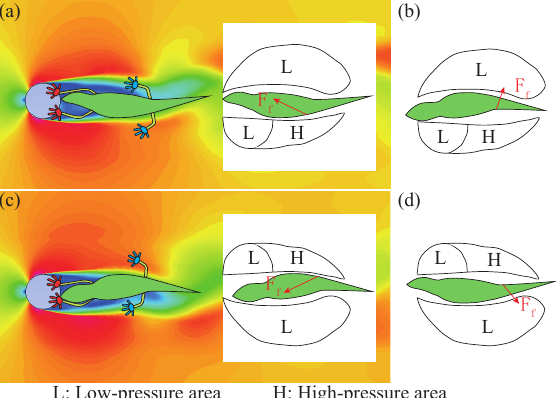
Figure 14. Influence of air pressure on a lizard behind an obstacle. When the pressure on the left is higher than that on the right, ( a ) the lizard swings to the left, ( b ) the lizard swings to the right; when the pressure on the right is higher than that on the left, ( c ) the lizard swings to the right, and ( d ) the lizard swings to the